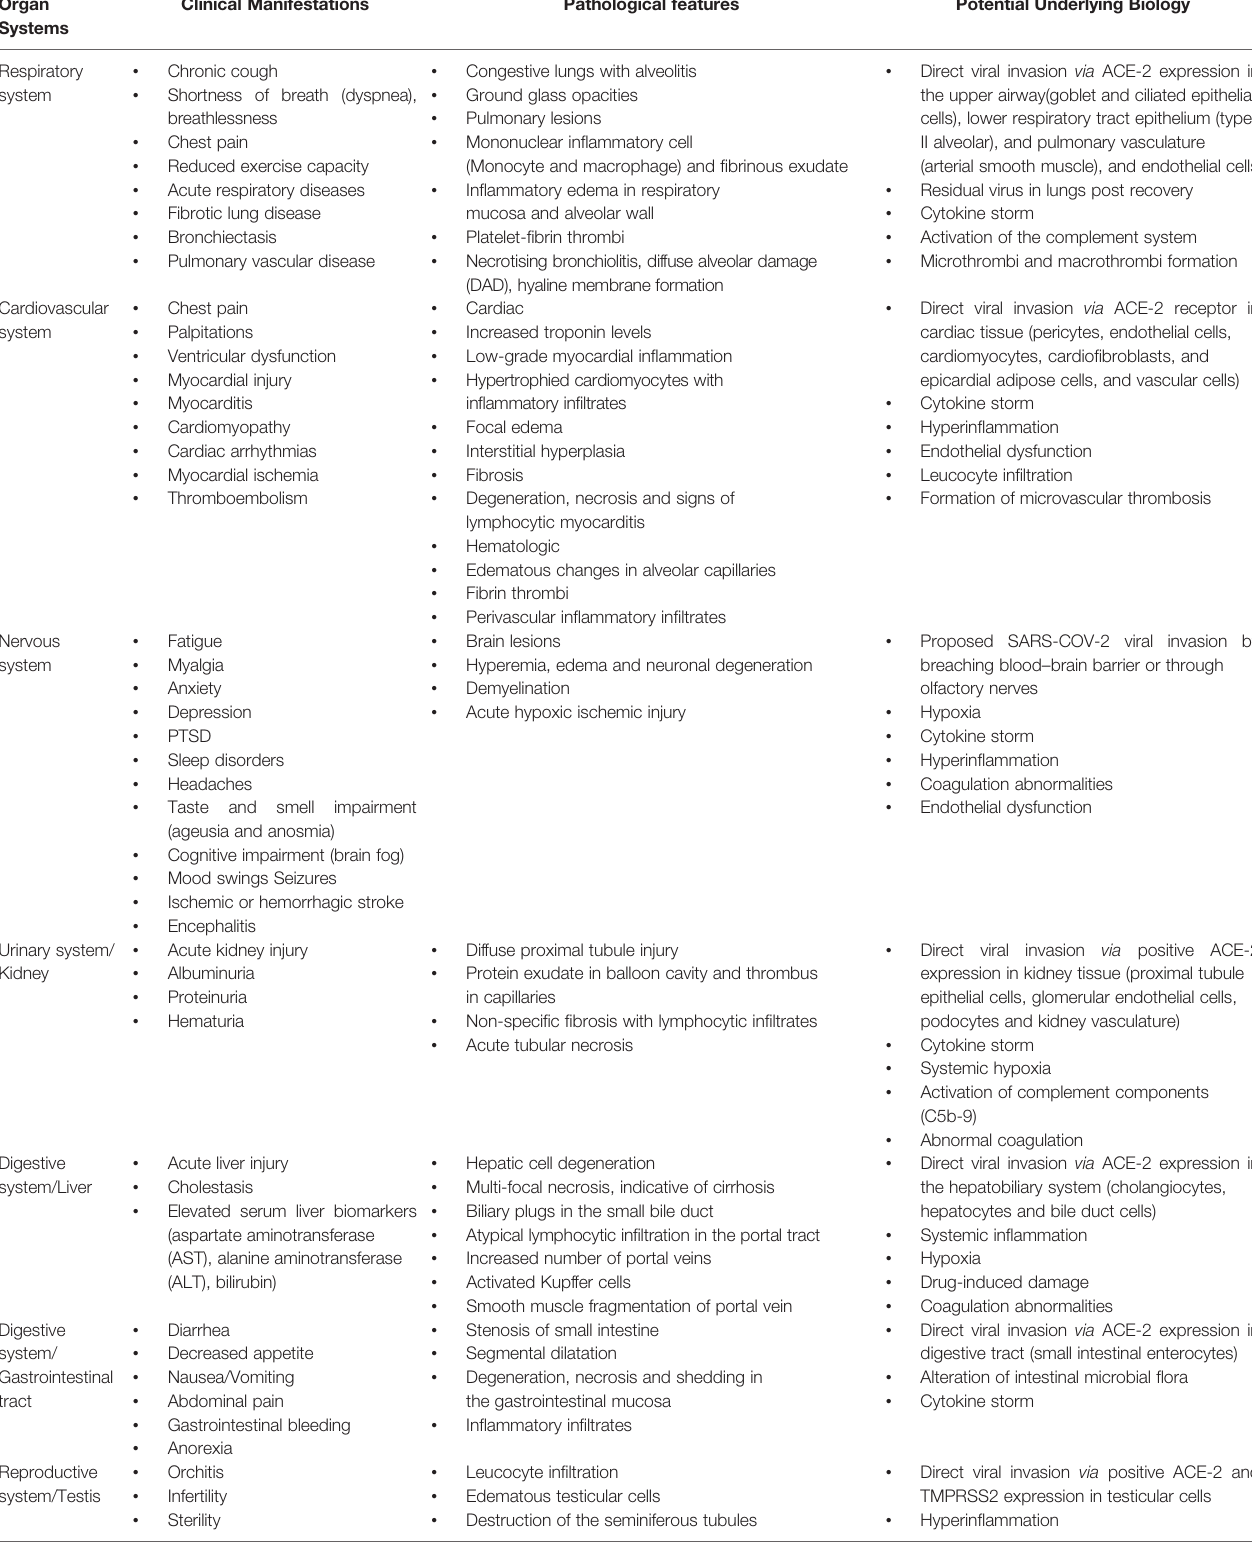
TABLE 1 | A summary of the clinical sequelae of COVID-19 (32, 111, 112). Organ Clinical Manifestations Pathological Systems